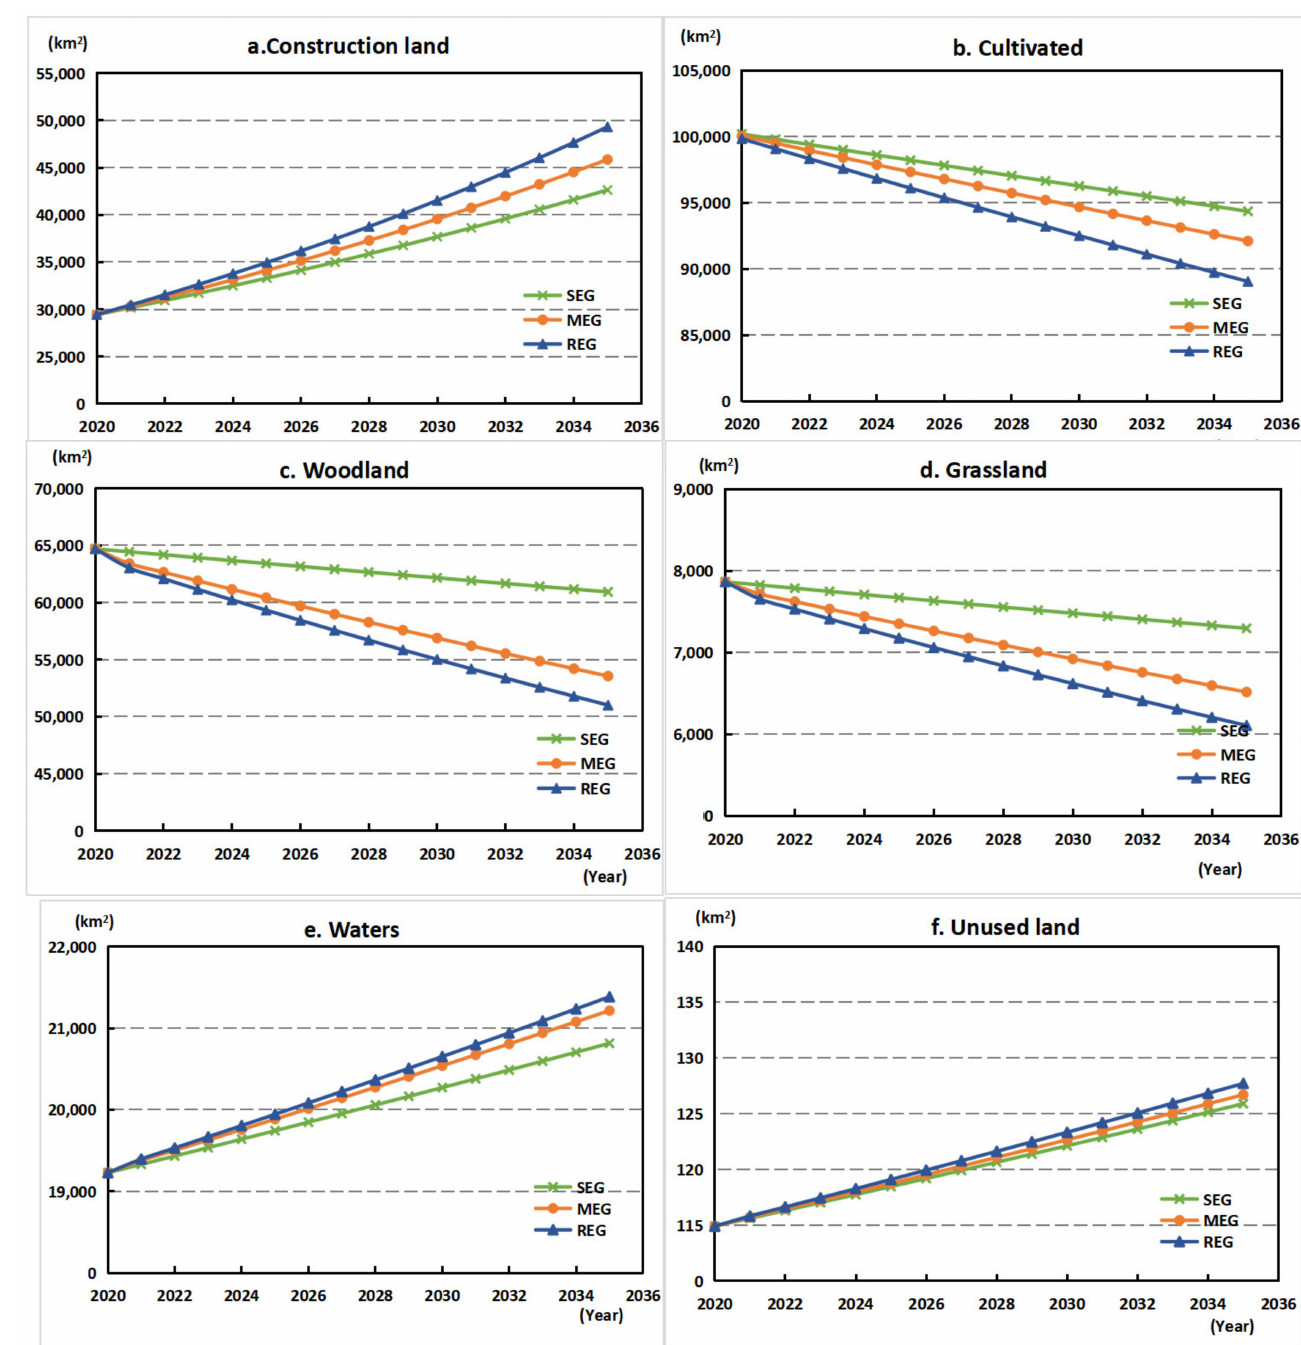
Figure 5. Changes in land-use quantities under different scenarios. ( a ) Construction land; ( b ) Cultivated; ( c ) Woodland; ( d ) Grassland; ( e ) Waters; ( f ) Unused